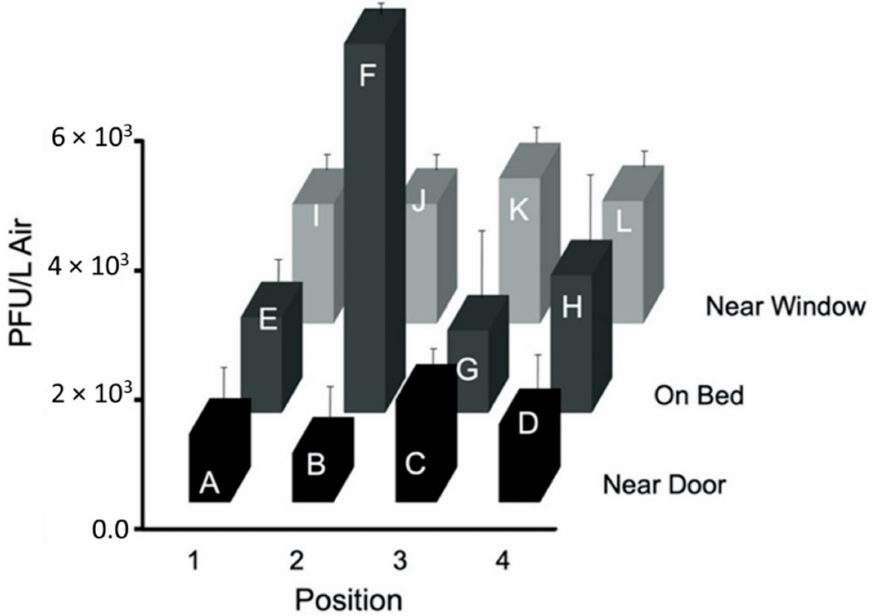
Figure 14. The average PFU/L Air for each PM2.5 sampler at the twelve locations A, B, C, D, E, F, G, H, I, J, and K in the 3 scale hospital model room using configuration ‘c’ (Table S7 in 4 Supplementary